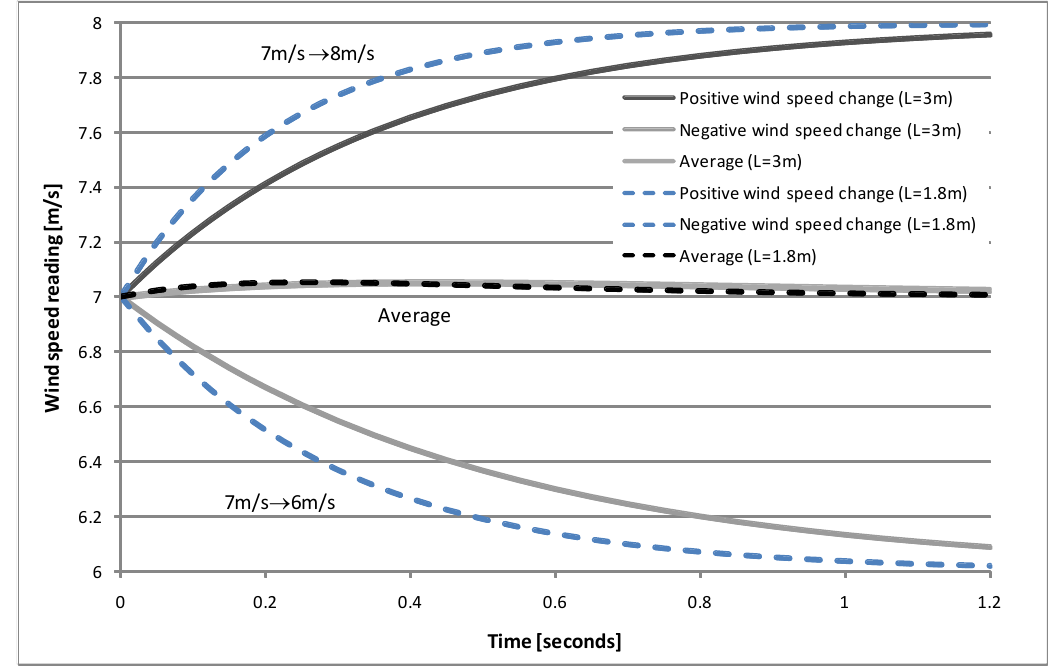
Figure 2. Illustration of the different response of a cup anemometer for positive and negative wind speed changes, respectively, for two values of the distant constant (1.8 m and 3